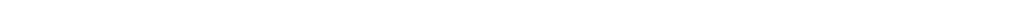
Table 2. Primary antibodies were detected using fl uorescently labelled secondary antibodies: goat α -rabbit IgG DyLight 680 and goat α -mouse IgG Dylight 800 (Thermo Scienti fi c). Odyssey CLx imaging system (LI-COR Biosciences) and Odyssey 2.1 software was used for detection and quanti fi cation of fl uorescence intensity. HRP-conjugated secondary antibodies were used in some instances for chemiluminescence detection and protein levels were quanti fi ed by densitometry and normalised against loading controls. Supplementary Fig. 12 for the uncropped immunoblots.